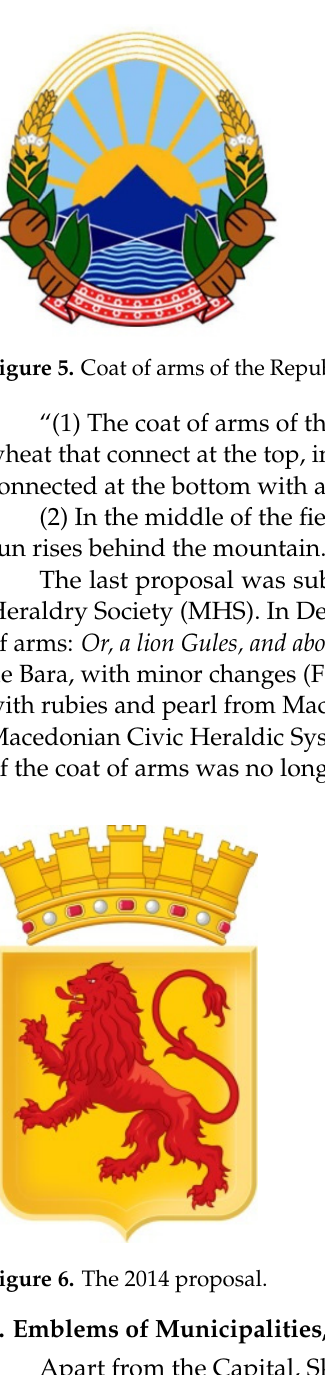
Figure 6. T he 2014